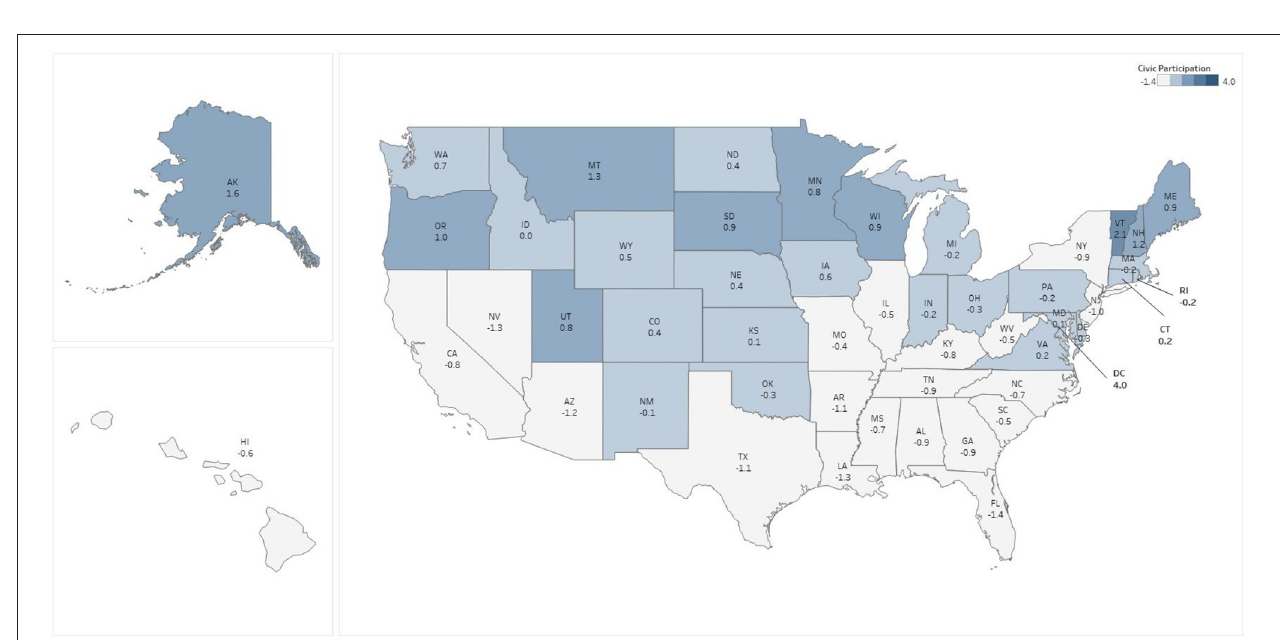
FIGURE 1 | Percent of persons reporting symptoms of anxiety or depression by state, February 2021.